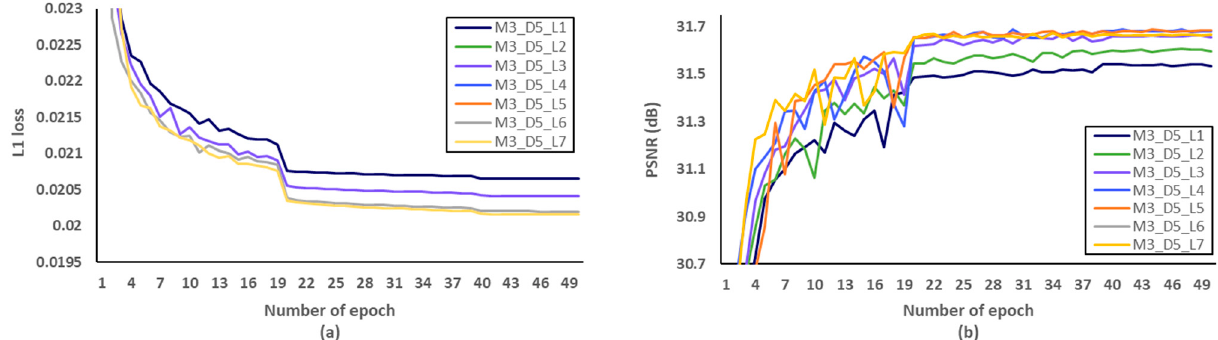
Figure 12. Verification of the number of dense layer (L) per a dense block in terms of SR performance. ( a ) L1 loss per epoch. ( b ) PSNR per epoch. Table 7. Verification of the number of dense block (D) per a MCDB in terms of network complexity. Num. of Parameters